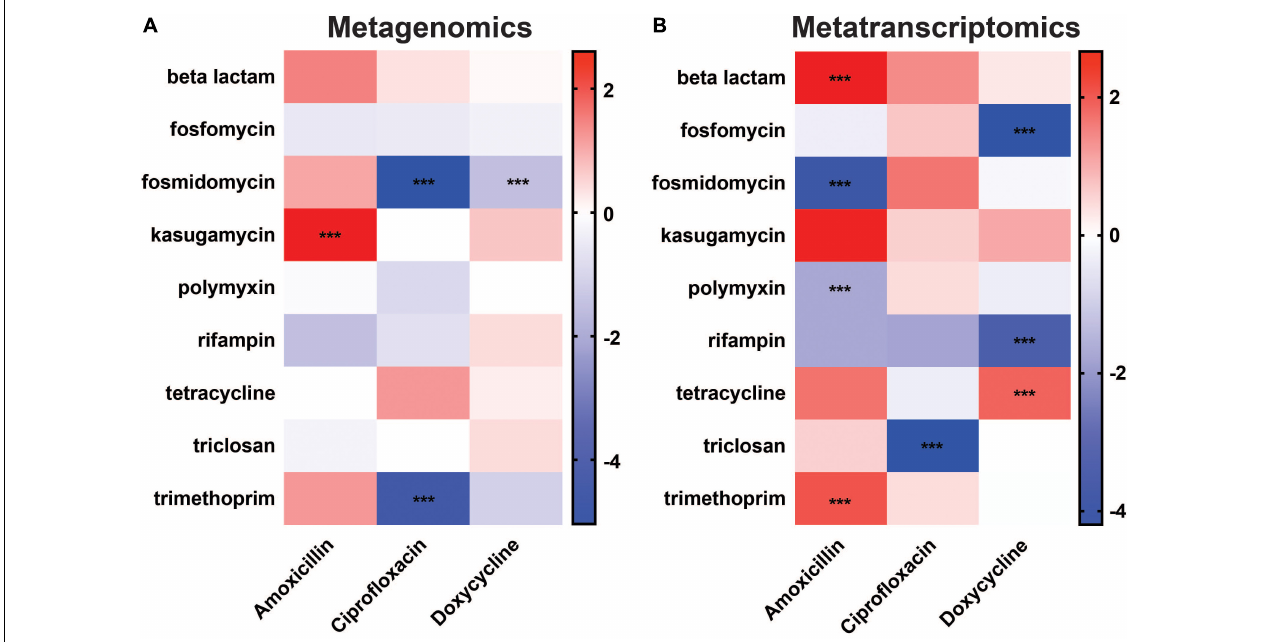
FIGURE 3 | Differential abundance of antibiotic resistance gene classes. Changes in ARG class abundances after antibiotic treatment observed in (A) metagenomic and (B) metatranscriptomic data. The color scale represents log 2 fold change (***log 2 FC ≥ 1.5/ ≤ –1.5 and padj < 0.05) (Full ARG class counts available in Supplementary Table S3